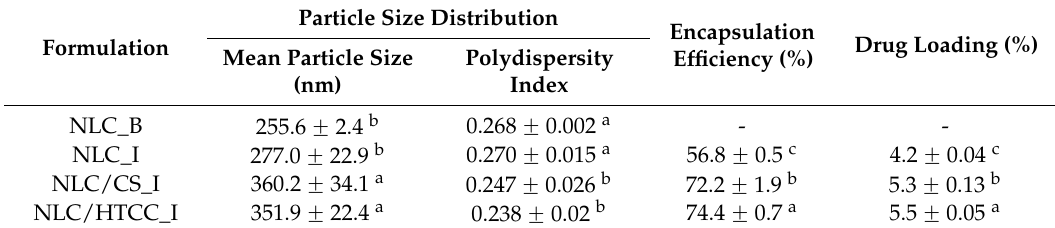
Table 2. Particle size distribution and encapsulation efficiency of indomethacin loaded NLC formulations.